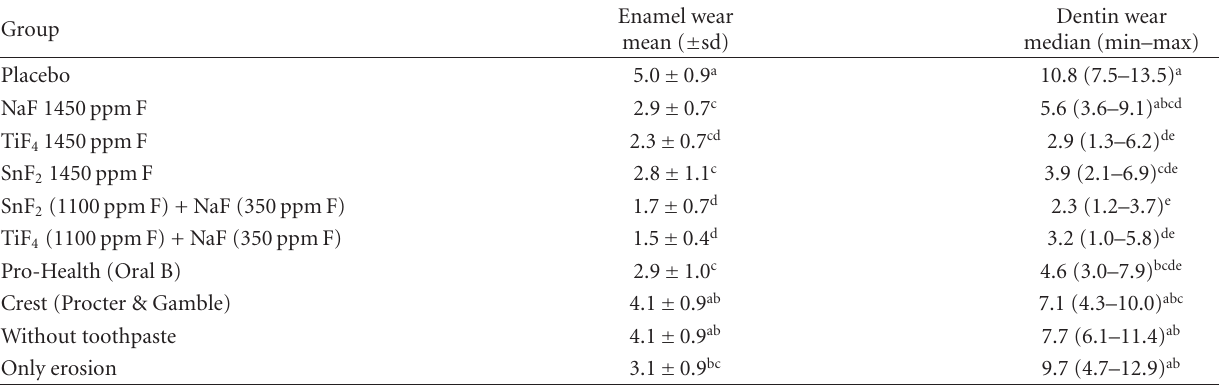
Table 2: The erosion-abrasion wear in the presence of the di ff erent toothpastes ( µ m).